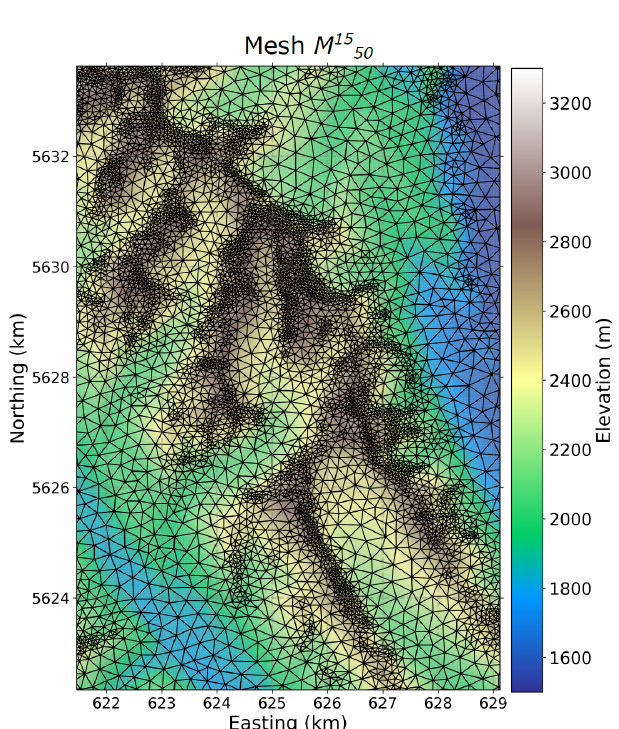
Figure 2. Variable-resolution triangular mesh used in this study over a sub-area of the Kananaskis domain. The location of this sub- area corresponds to the red-shaded area shown in Fig. 1b. The un- derlining DEM was taken from the SRTM mission at